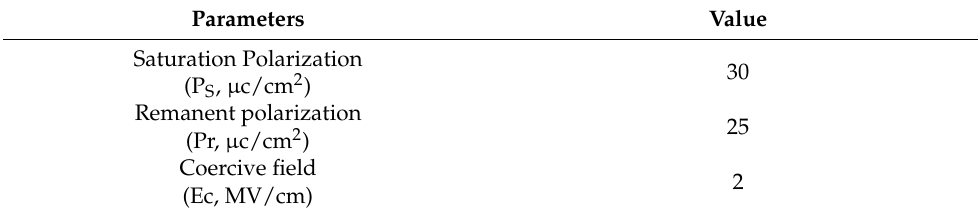
Table 2. Ferroelectric parameters of HfO 2